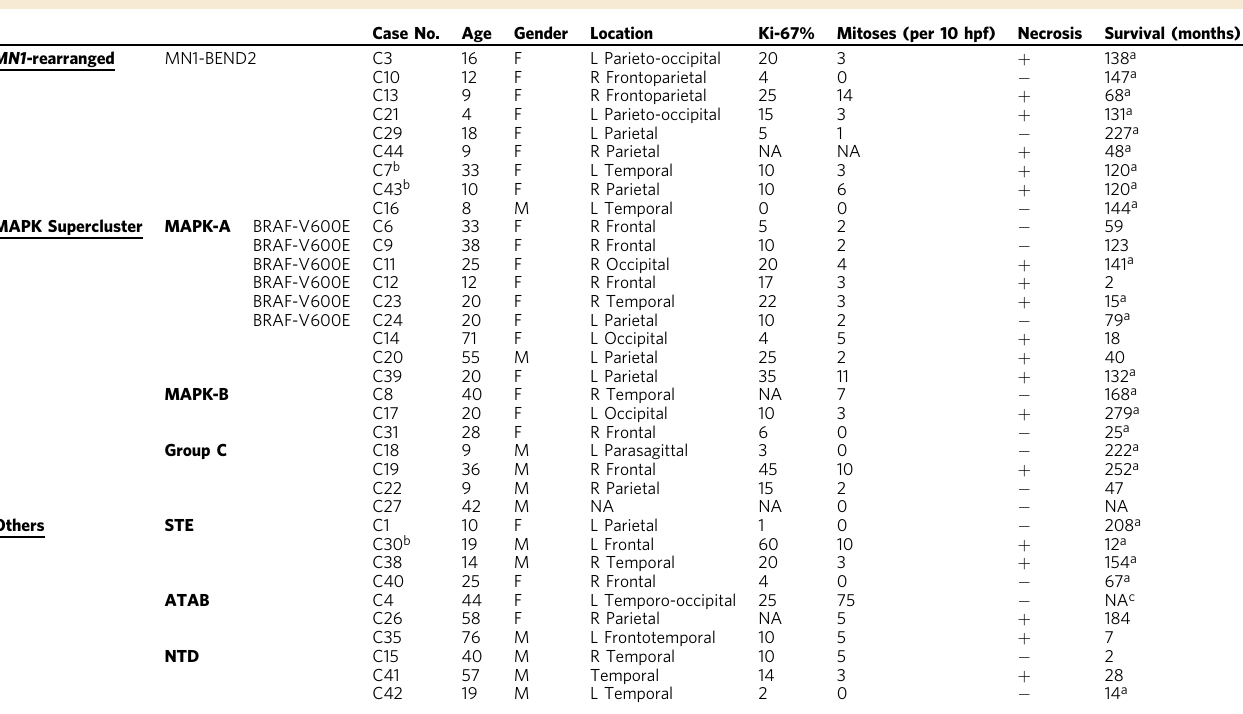
Table 1 Patient demographic and tumor pathology data. Case No. Age Gender Location